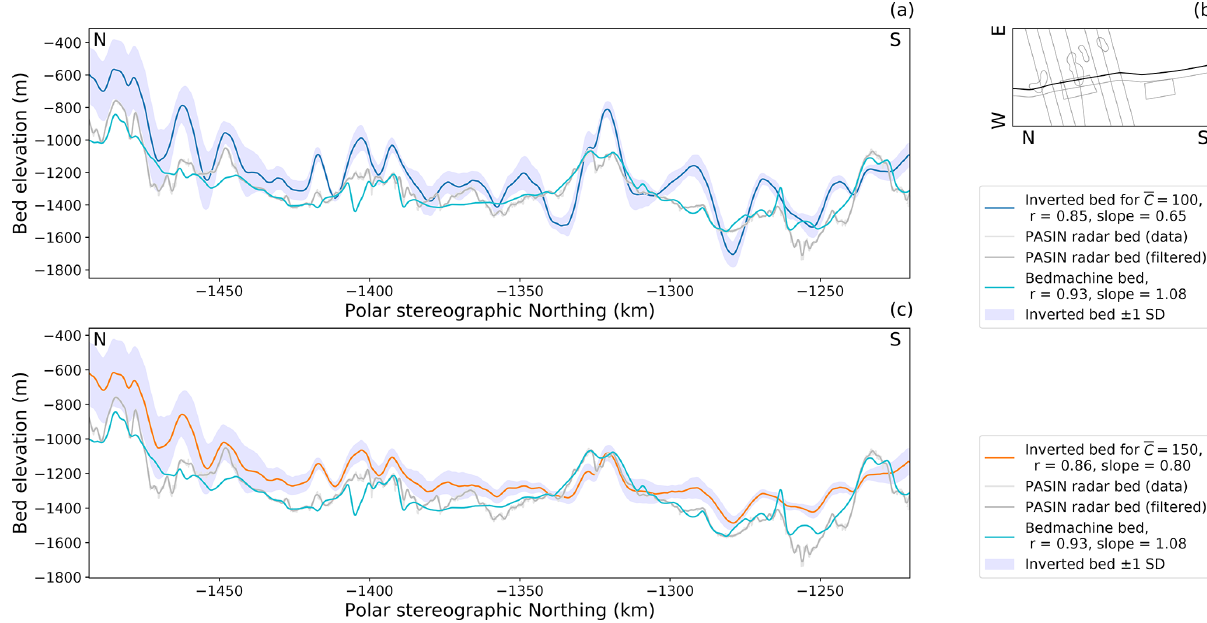
Figure 7. (a) Comparative plot of inverted bed topography with mean non-dimensional slipperiness C = 100 with along-flow radar-sounded bed topography. Bed topography is given in three forms: unfiltered bed picks from the 2019/20 airborne surveys (Jordan and Robinson, 2021); a version of the same filtered to 2km wavelengths to be more representative of the detail we might expect to image in our inversion; the bed profile extracted from BedMachine Antarctica (Morlighem et al., 2020). The envelope around the inverted bed topography shows plus or minus 1 standard deviation. Standard deviations are a measure of variability between overlapped patches and should not be interpreted as a measure of the error in the bed topography or bed slipperiness. The correlation coefficients ( r ) and slopes given are the results of a linear regression between the inverted bed or the BedMachine Antarctica bed and the filtered radar bed. (b) Profile location within the inverted grid. (c) As for panel (a) but with mean non-dimensional slipperiness C = 150.